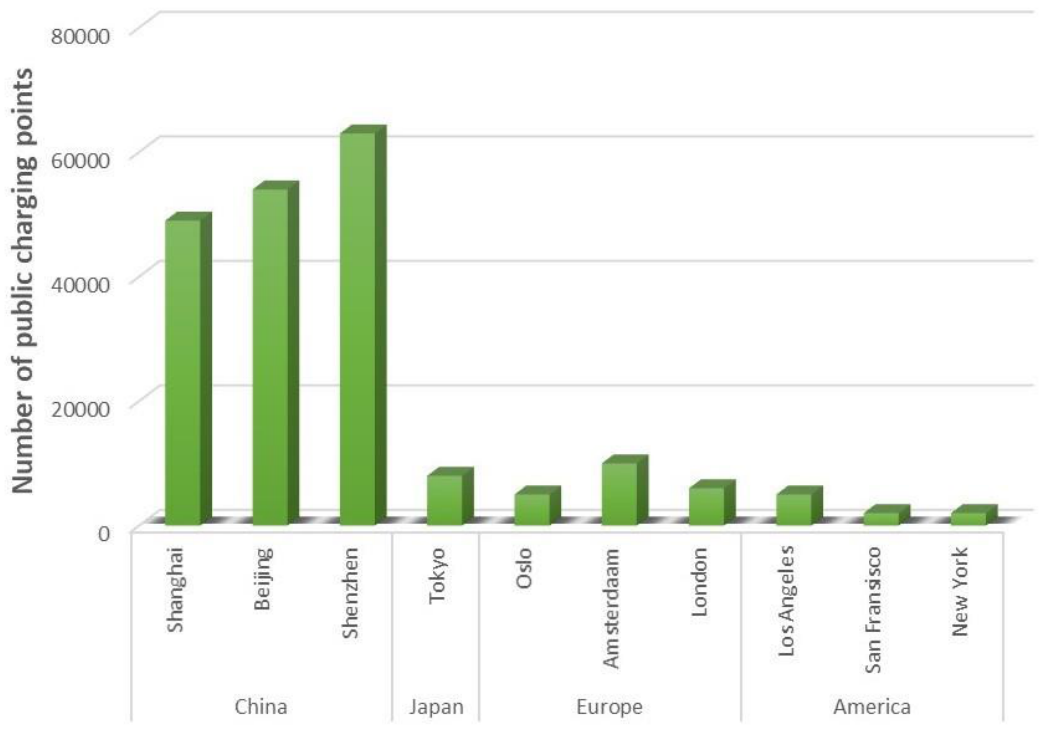
Figure 7. Number of public charging points in metropolitan areas.